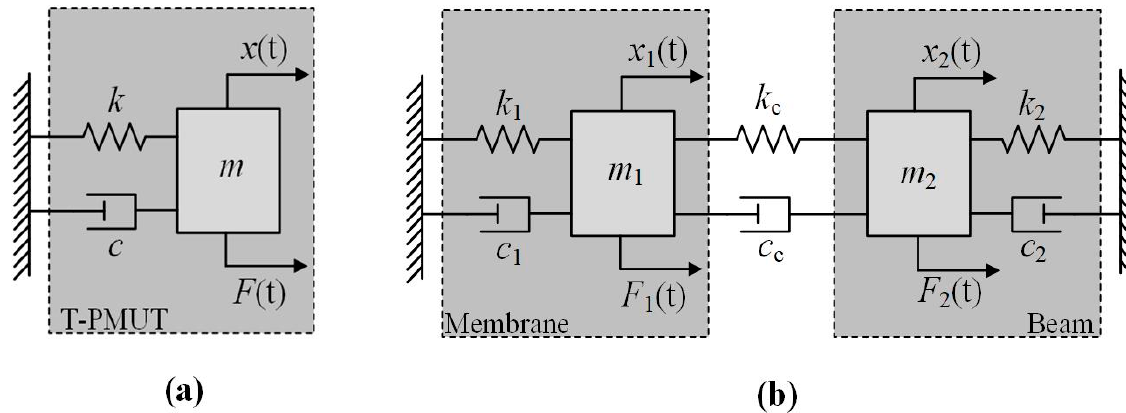
Figure 2. Schematic of the equivalent models for ( a ) T-PMUT and ( b ) BM-PMUT.